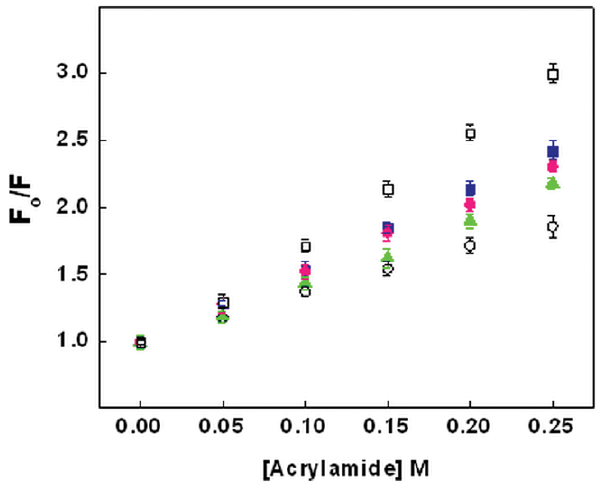
Figure 5. Stern-Volmer plot obtained from acrylamide quench- N ing of chymopapain. Plot at pH 7.4 (- & -), pH 3.0 (- # -), pH 1.5 (- m -), -) and in the presence of 6M GuHCl (- % -). Protein pH 1.0 (- concentration was 8 m M.